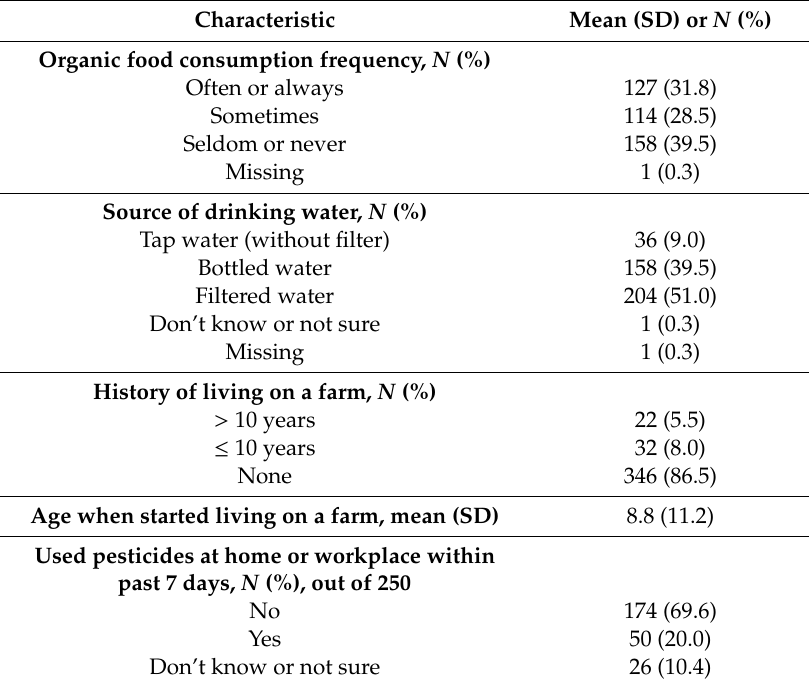
Table 4. Environmental factors among study